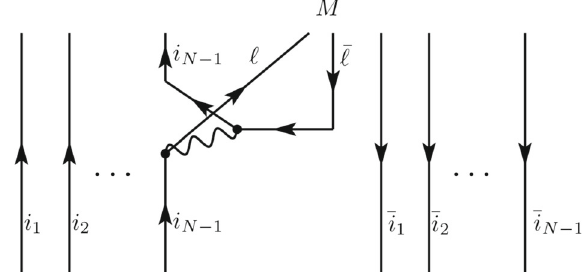
Fig. 4 Feynman diagrams for the decay of an excited tetraquark to the ground state by emitting a light meson. The diagrams with the deexci- tation from the antidiquark only produce a factor of